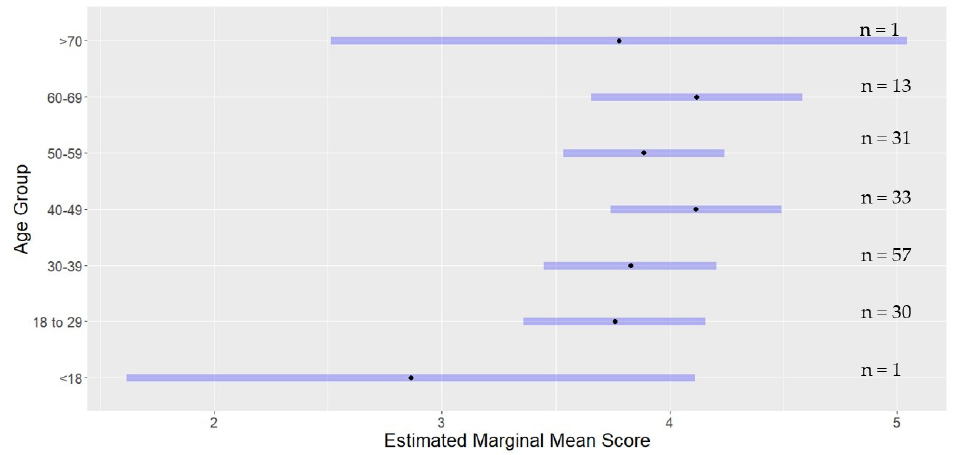
Figure 6. Estimated Marginal Means Distribution by ORGANISATION for Safety Communication.